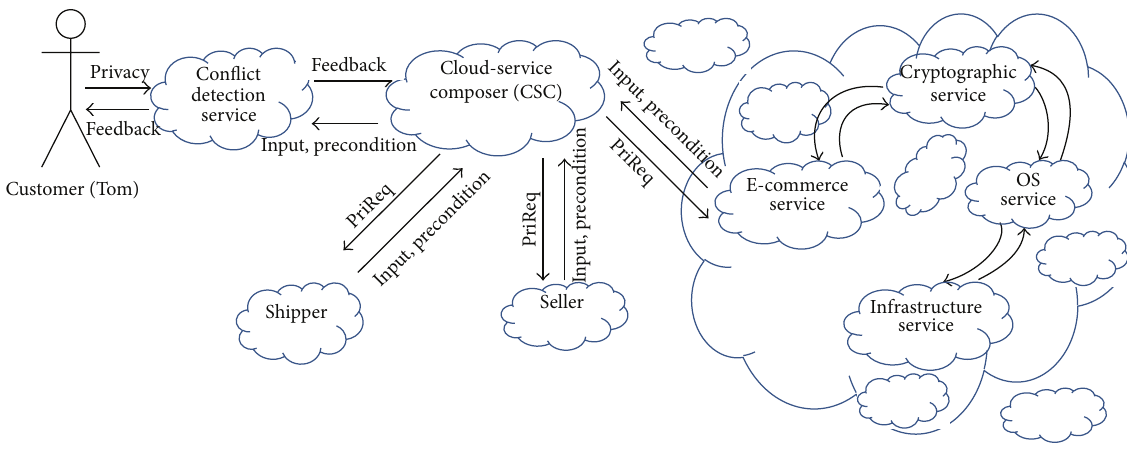
Figure 4: Case of online